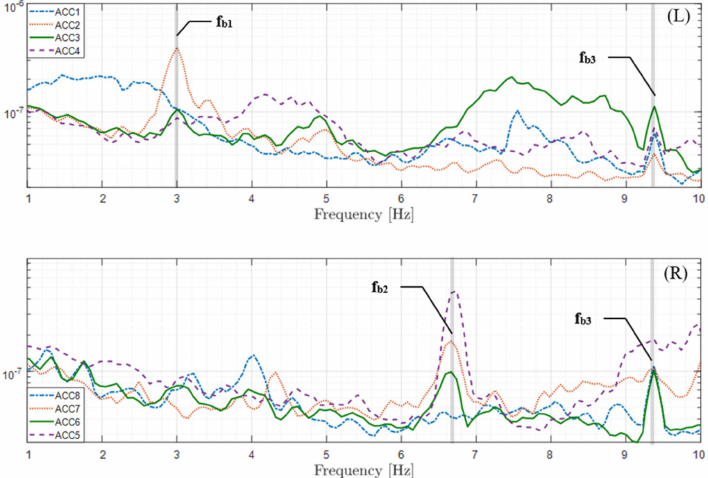
Figure 4. PSDs obtained from the acquisitions in Case 1; data from accelerometers positioned in the left sidewalk (L) and in the right sidewalk